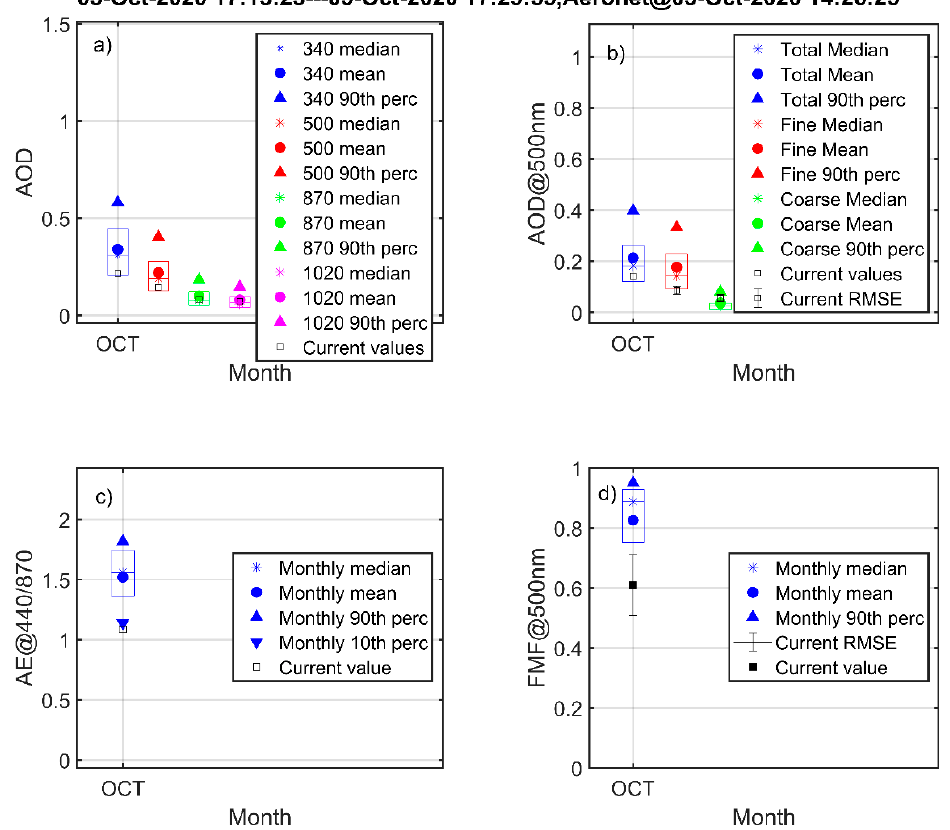
Figure 2. ( a ) AOD at 340 nm, 500 nm, 870 nm and 1020 nm. ( b ) Total AOD, FMAOD and CMAOD at 500 nm. ( c ) AE at 440/870. ( d ) FMF at 500 nm. The title shows the time interval over which ALH was detected and the time when AERONET data were available (‘Aeronet@’).